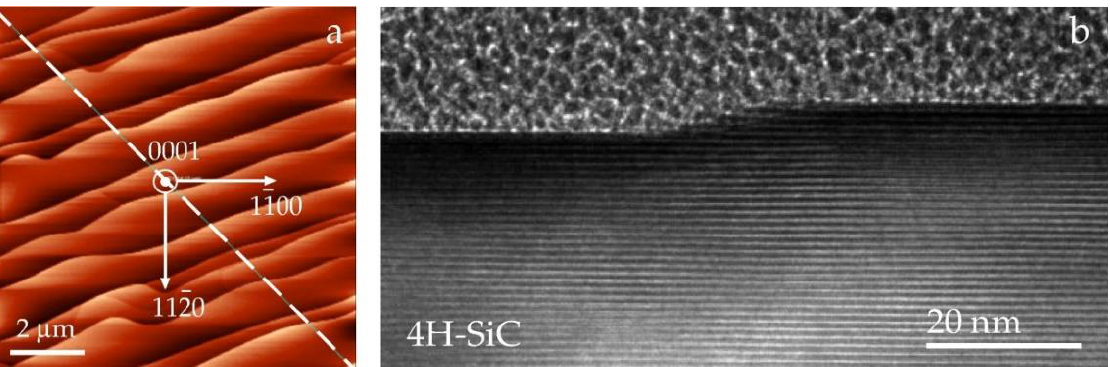
Figure 2. ( a ) AFM image of the terrace-stepped surface morphology of the Si-face of 4H-SiC. The annealing temperature is 1450 °C. The plot for height against distance (not shown) is obtained along the dashed line. ( b ) HRTEM image of a single step on a 4H-SiC surface imaged along a zone axis [1-210] . The period of the stripes corresponds to the unit cell parameter.